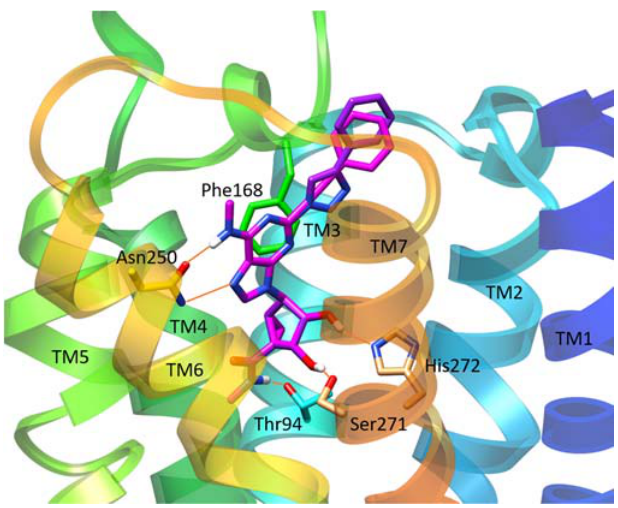
Figure 7. Comparison of the docking of a 2-(phenylethynyl) agonist MRS5644 ( 14 , magenta) and the corresponding 2-(phenyl-triazolyl) agonist MRS7110 ( 15 , purple) at the hybrid hA 3 AR model based on a A 2A AR- β 2 template [48]. The positions of the terminal phenyl rings overlap to a large degree. The residue Ballesteros–Weinstein notation is: Thr94 (3.36), Phe168 (EL2), Asn250 (6.55), His272 (7.43), Ser271 (7.42) and His272 (7.43).